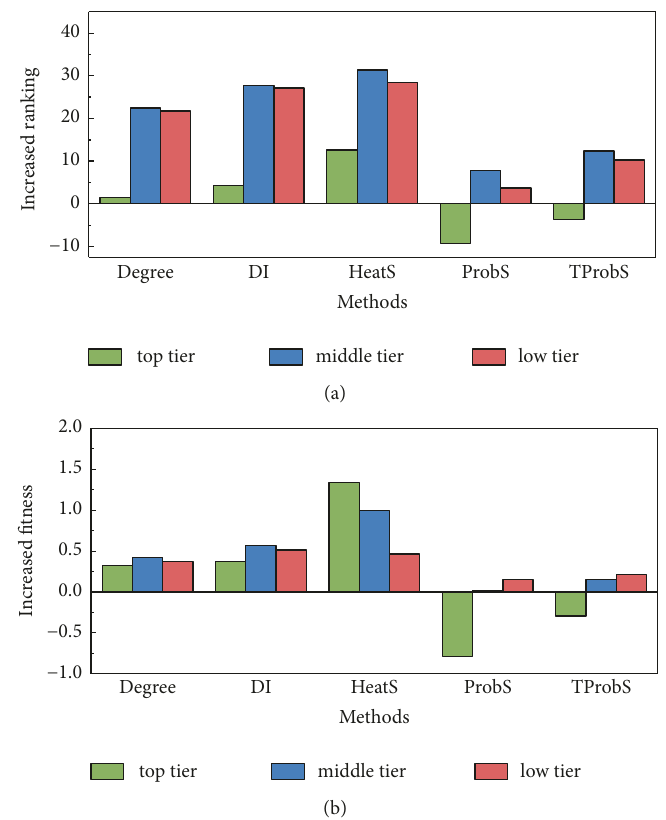
Figure 2: Panel (a) is the average increase of fitness ranking for the three different tiers of countries for the time period 2008–2015. The number of goods added for each country is set to 𝐿 = 20 . Panel (b) is the average increased fitness value of those three